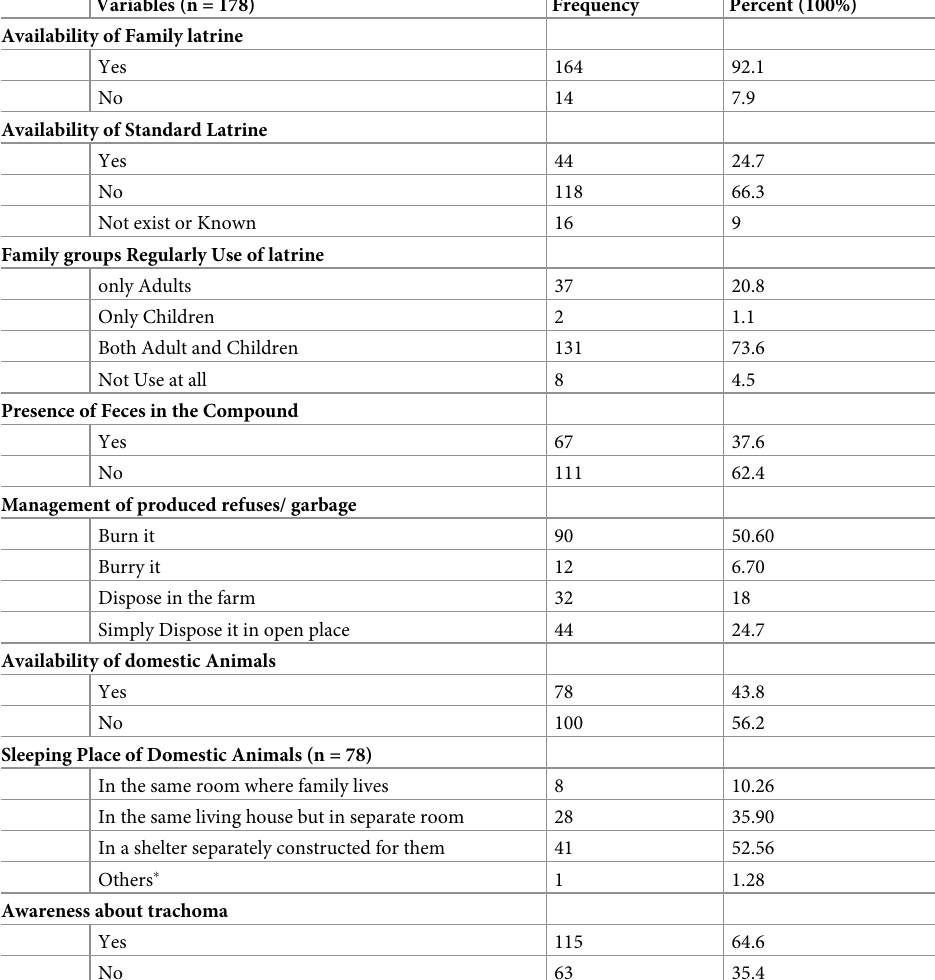
Table 3. Family sanitation, hygiene and awareness about trachoma of the study participants at Arsi Negele Town, West Arsi Zone, Oromia, Southern Ethiopia, December, 2019. Variables (n =